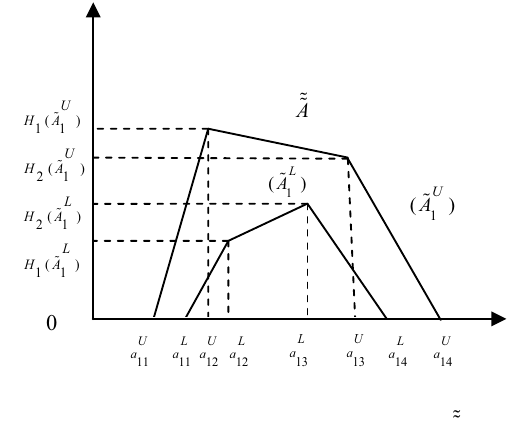
Fig.1. Membership functions of IT2FSs of A